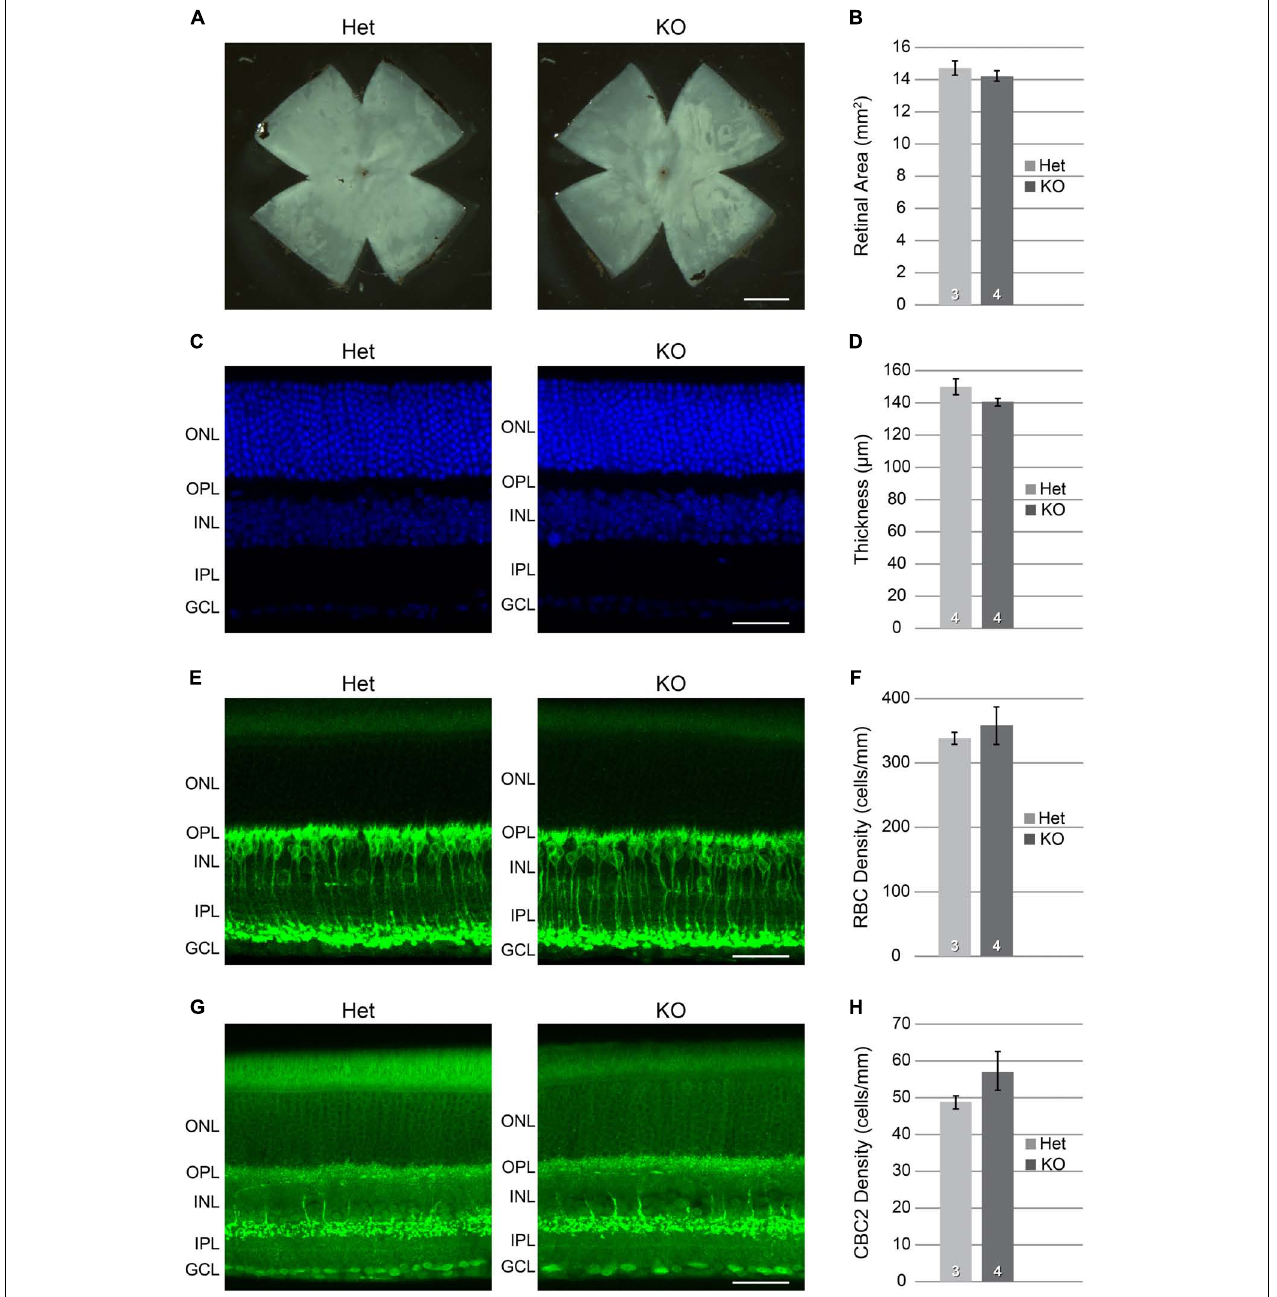
FIGURE 6 | Xkr8 KO versus heterozygous (Het) mice showed no difference in their total retinal area (A,B) , nor in the total thickness of the retina (C,D) . Individual retinal layers also did not differ (not shown). The densities of RBCs (E,F) and CBC2s (G,H) were slightly, though not significantly greater in the KO retinas ( p > 0.1). n = the number of retinas examined in each condition. Scale bar = 1 mm for (A) ; = 100 µ m for (C,E,G)